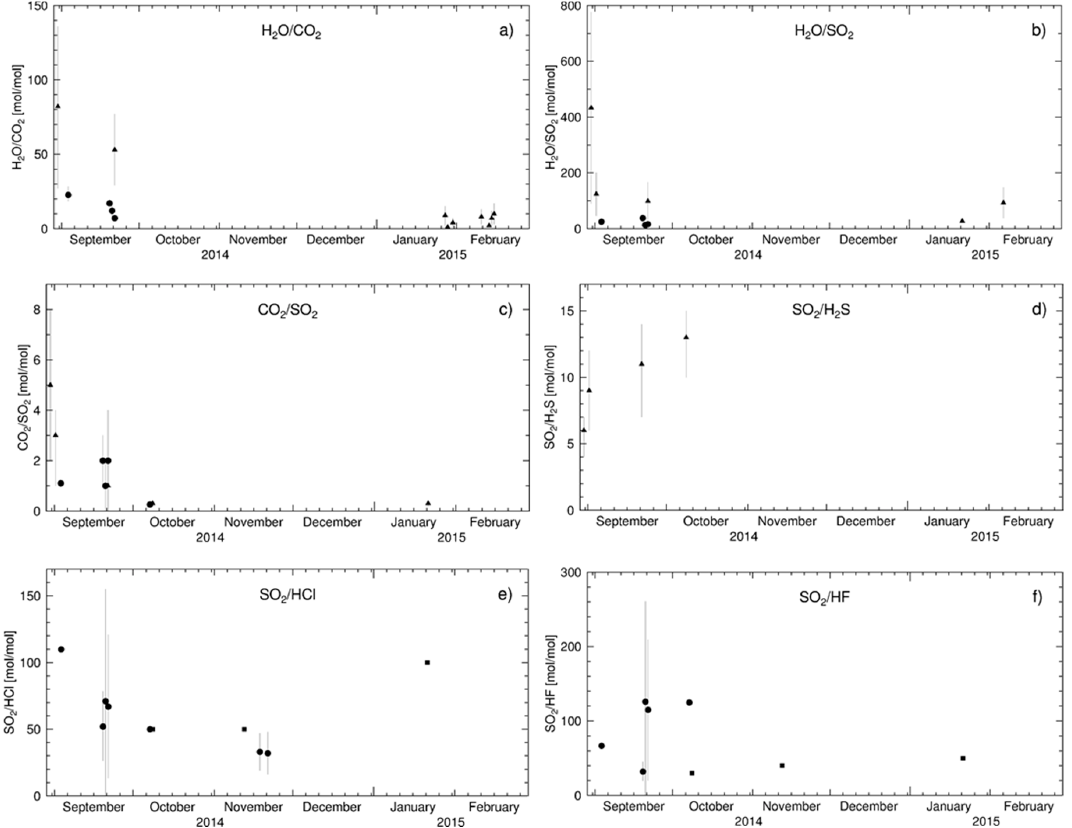
Figure 8. The time series of daily averaged gas ratios ( a ) H 2 O/CO 2 ; ( b ) H 2 O/SO 2 ; ( c ) CO 2 /SO 2 ; ( d ) SO 2 /H 2 S; ( e ) SO 2 /HCl; ( f ) SO 2 /HF. Measurements made by OP-FTIR, MultiGAS, and Filter Pack are shown as circles, triangles, and squares, respectively. Vertical gray bars indicate uncertainty.